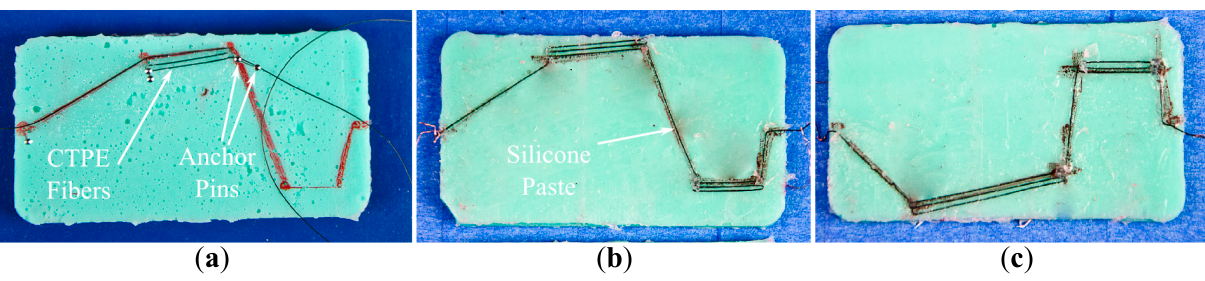
Figure 5. ( a ) The integration step of CTPE-based strain sensors on the molded silicone blocks. The designed and realized sensor morphologies for bending ( b ) and twisting ( c